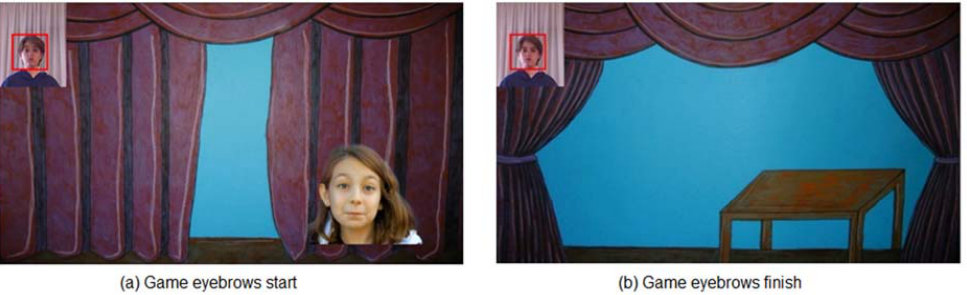
Figure 4. Game scenarios SONRIE. Eyebrow raising game.